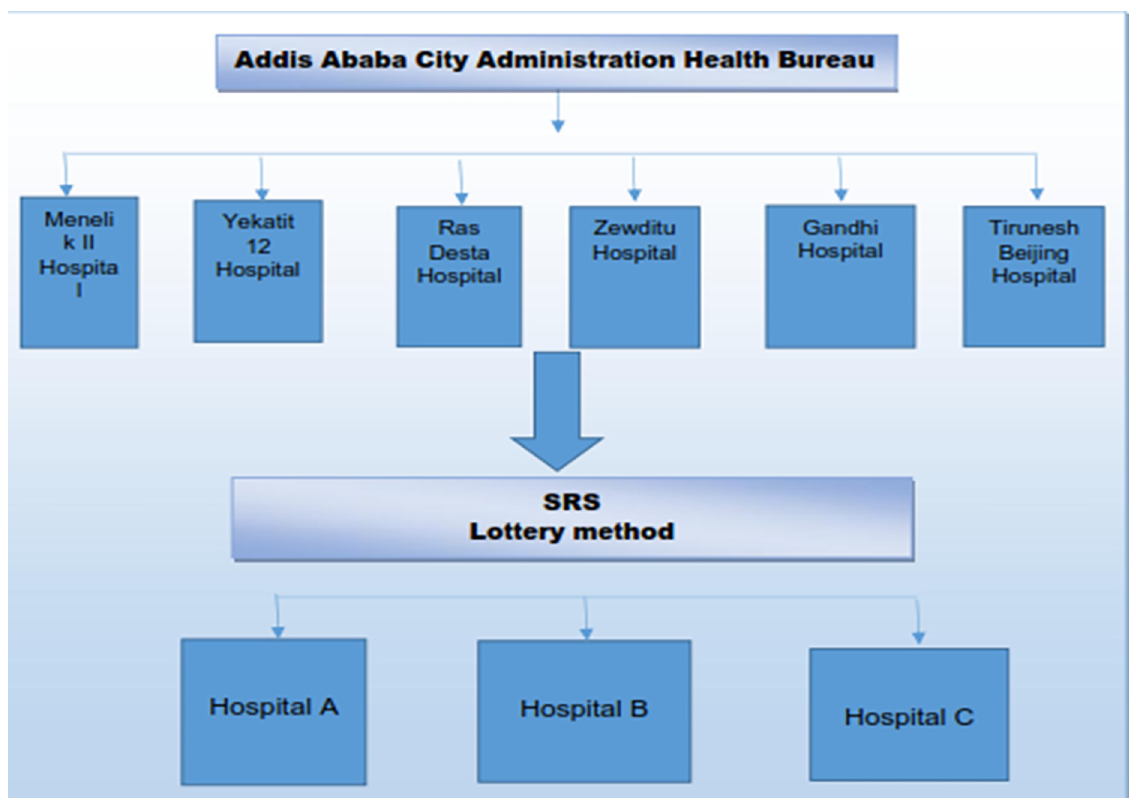
Fig 2. Number of hospitals selected from Addis Ababa City Administration, February 2018.